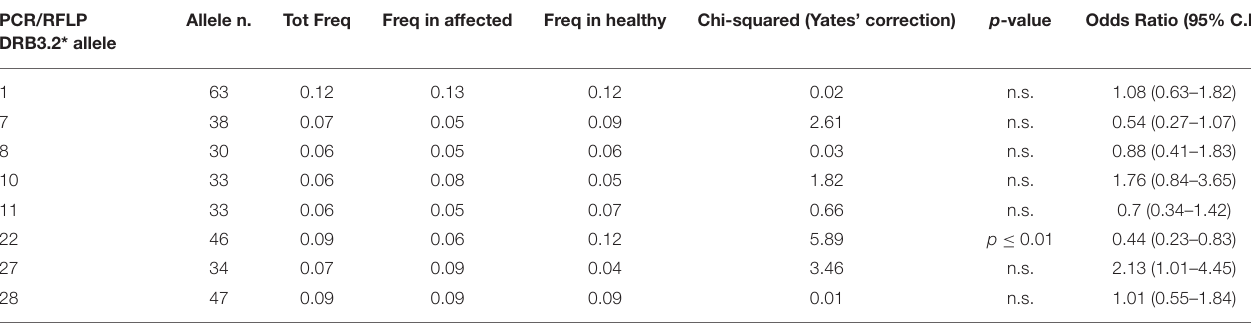
TABLE 1 | BoLA DRB3.2 PCR/RFLP alleles with a higher frequency than 5% in 260 animals. PCR/RFLP Allele n. Tot Freq Freq in affected Freq in healthy Chi-squared (Yates’ correction) p -value Odds Ratio (95% DRB3.2* allele